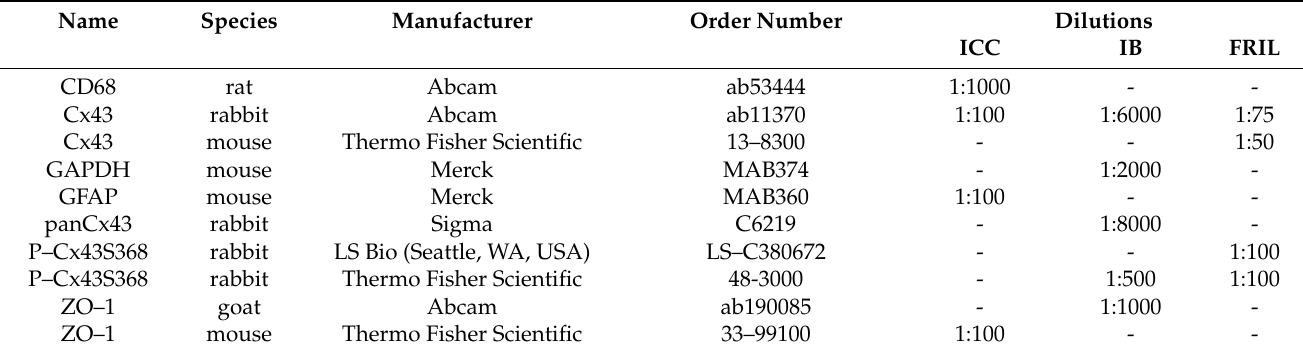
Table 2. Data of primary antibodies in alphabetical